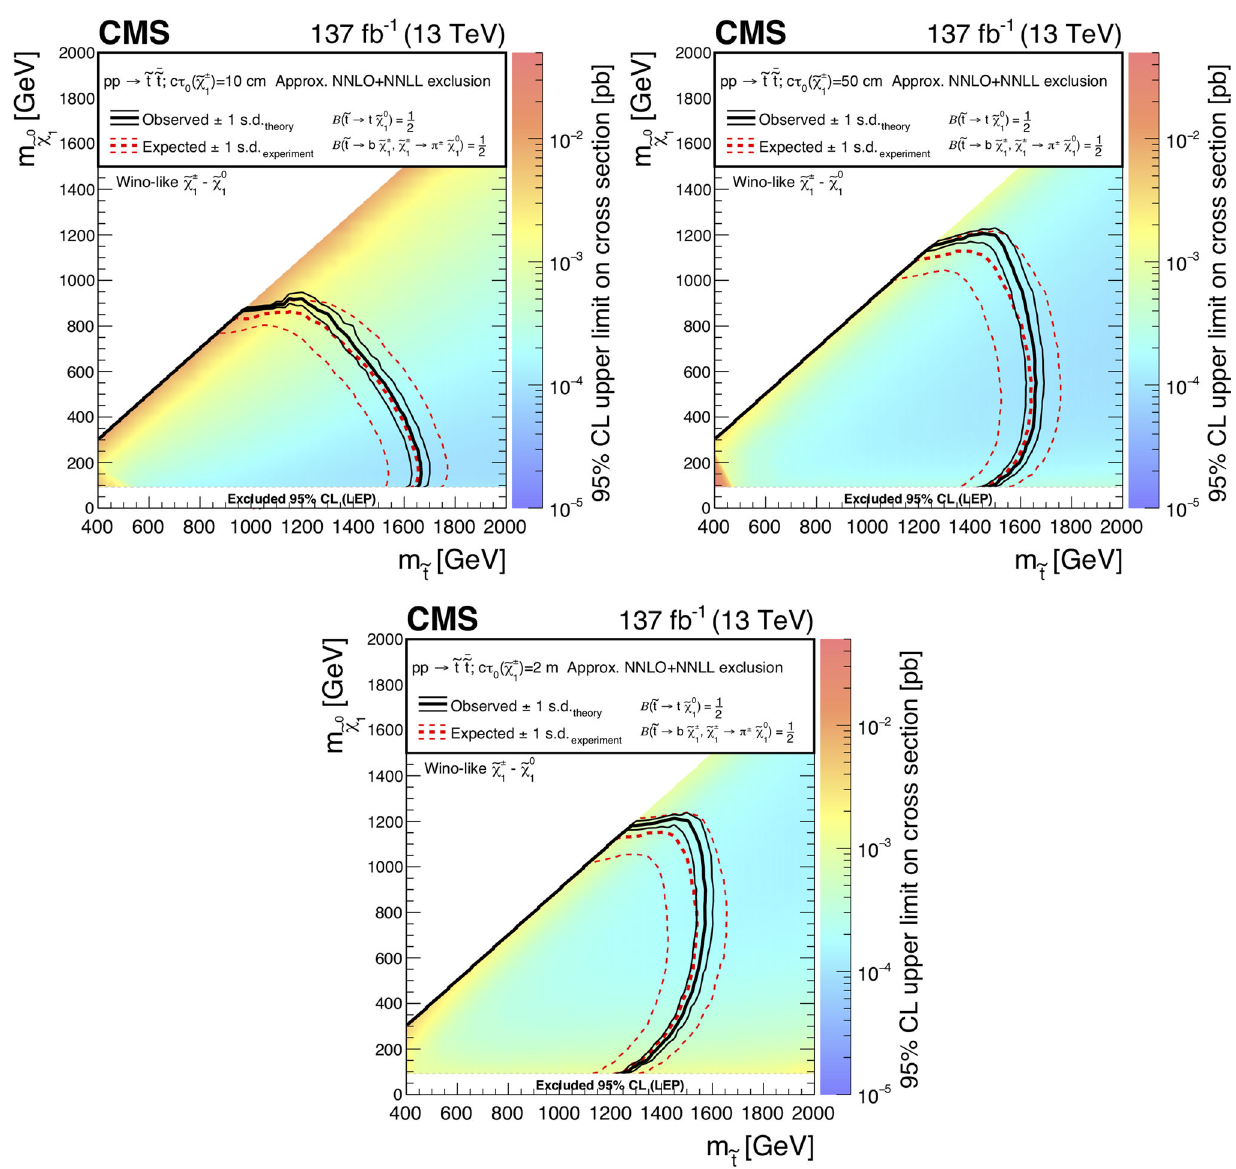
Fig. 19 Exclusionlimitsat95%CLfortopsquarkpairproductionwith ) = (upper left) 10cm, (upper right) 50cm, and (lower) 200cm. c τ 0 ( ˜ χ ± 1 The area enclosed by the thick black curve represents the observed exclusion region, while the dashed red lines indicate the expected lim- its and their ± 1 standard deviation (s.d.) ranges. The thin black lines show the effect of the theoretical uncertainties in the signal cross sec-